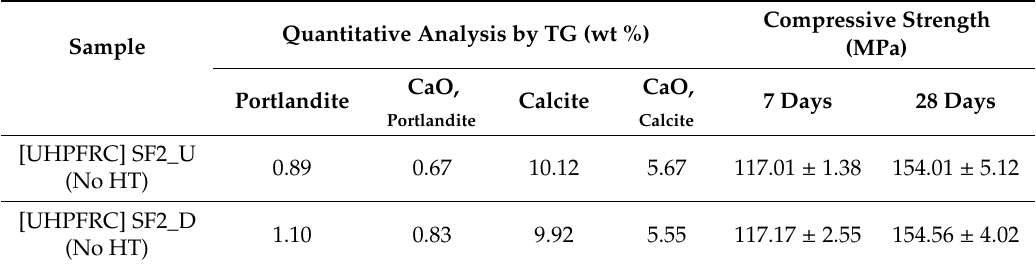
Table 4. Portlandite and calcite contents and compressive strength of ambient-cured